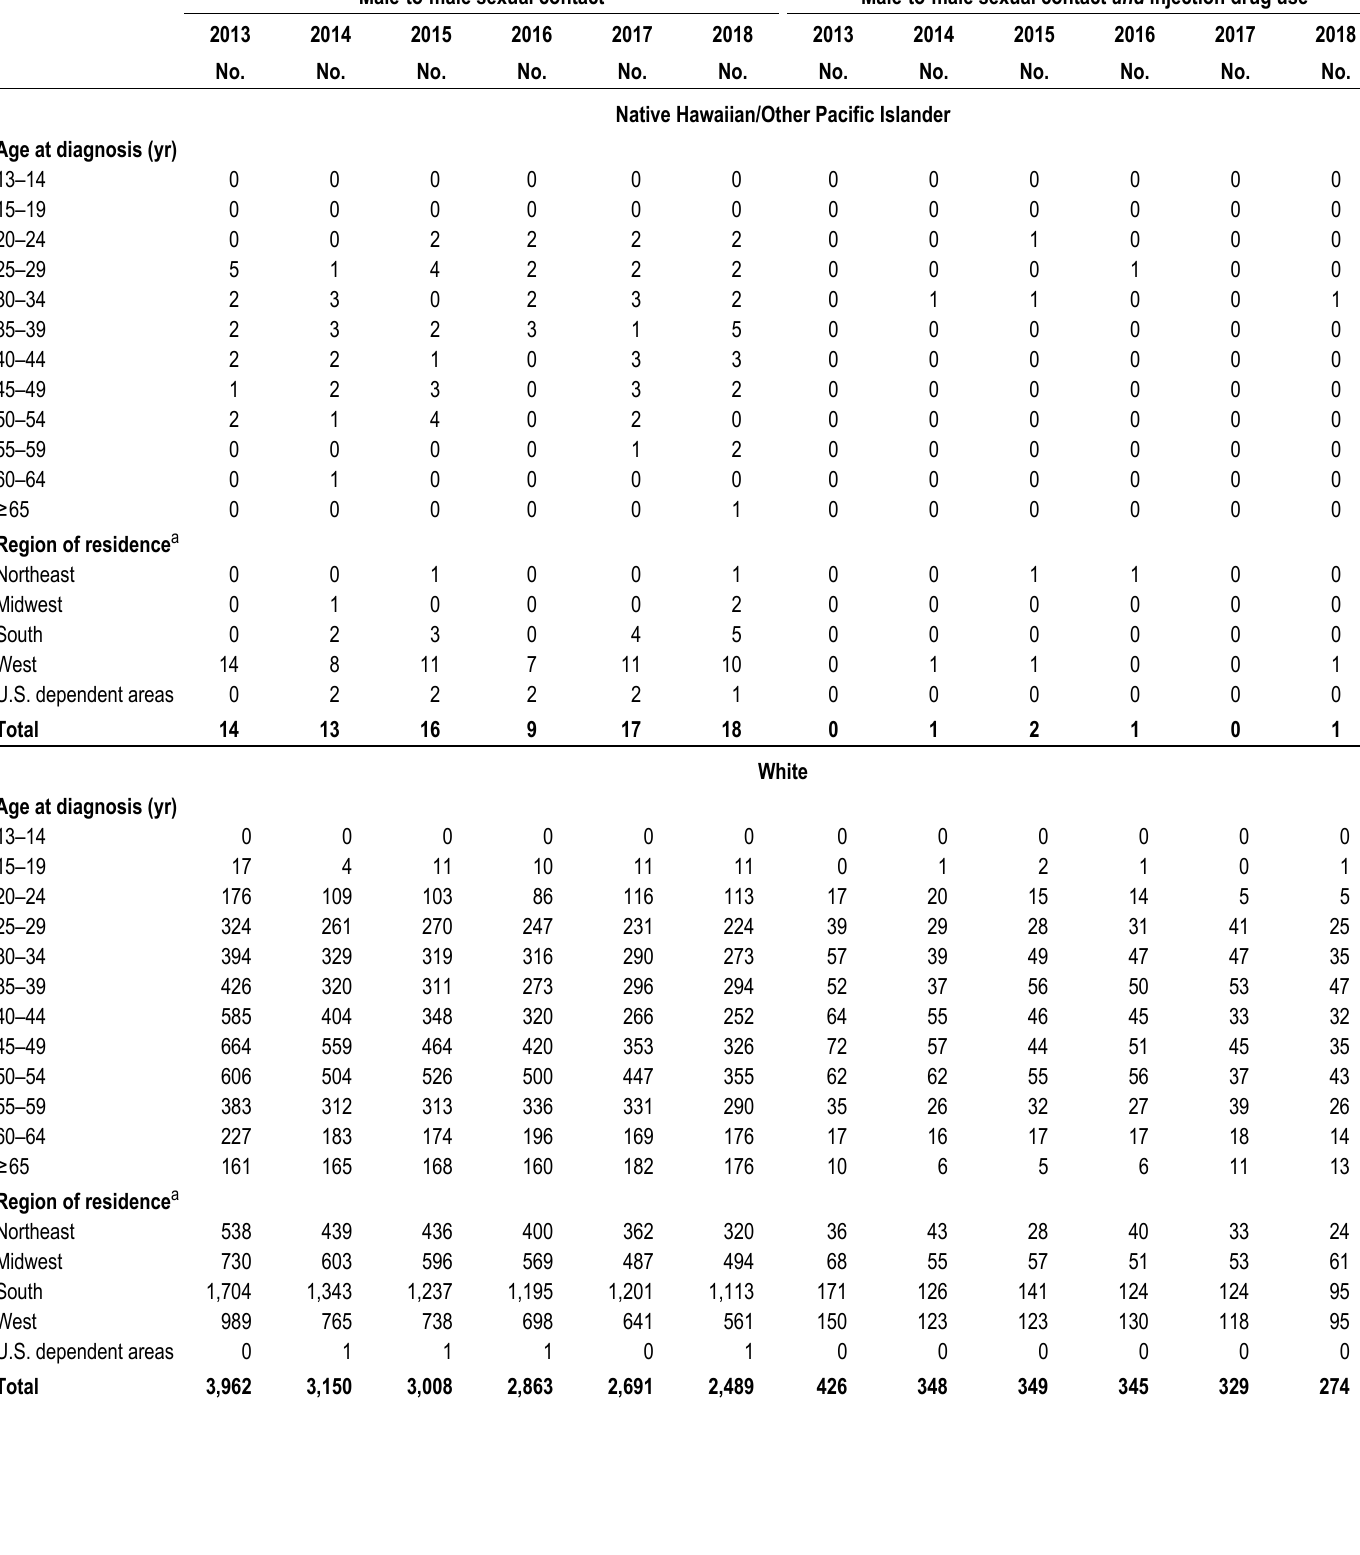
Table 10b. Stage 3 (AIDS) attributed to male-to-male sexual contact and male-to-male sexual contact and injection drug use, by selected characteristics, 2013–2018—United States and 6 dependent areas (cont) Male-to-male sexual